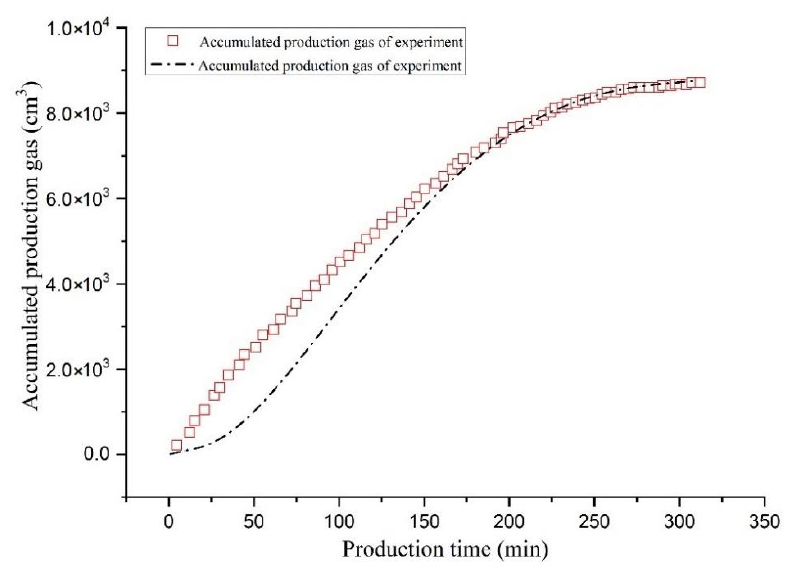
Figure 4. Accumulated production gas compared with Masuda’s experiment.